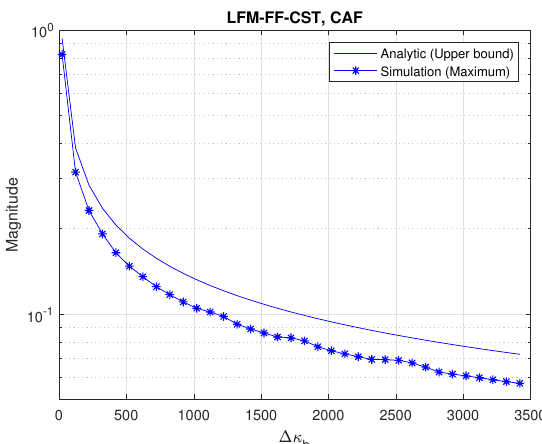
Figure 8. Cross-ambiguity function (CAF) of LFM-FF signals vs. ∆ κ b